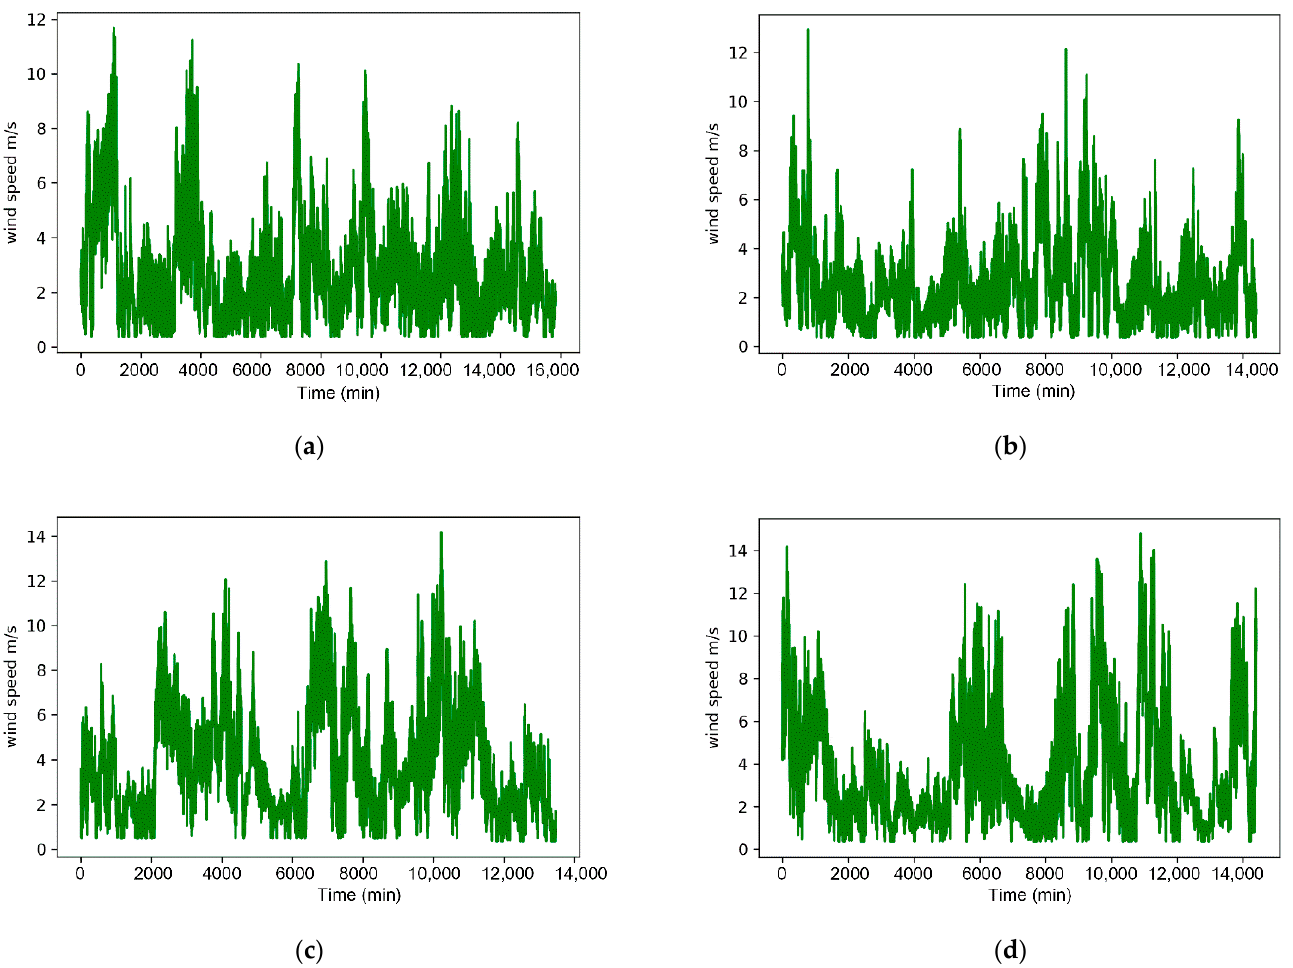
Figure 5. Time series representation of wind speed for the four datasets. ( a ) Time series representation of spring wind speed dataset; ( b ) time series representation of summer wind speed dataset; ( c ) time series representation of autumn wind speed dataset; ( d ) time series representation of winter wind speed dataset.